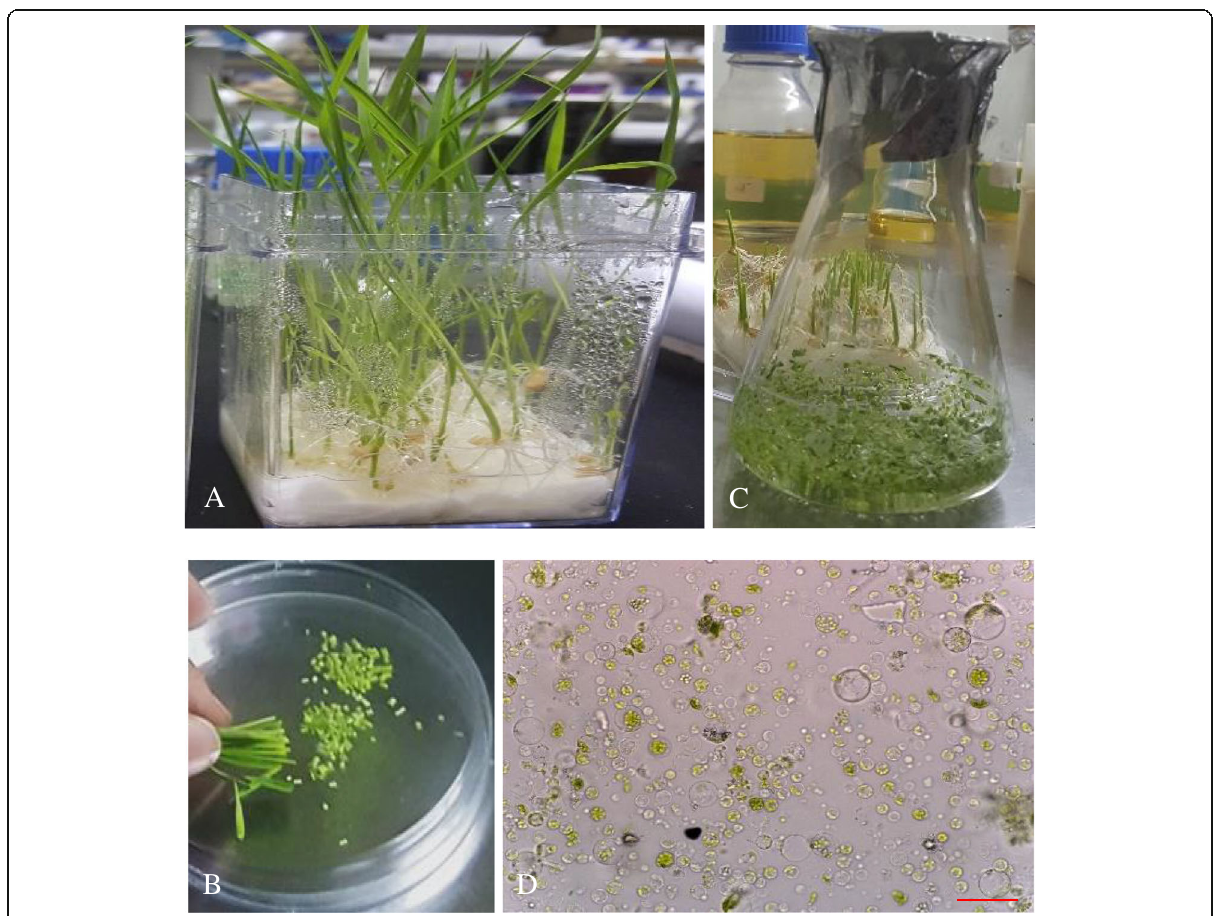
Fig. 1 Fourteen-day-old rice seedlings used for protoplasts isolation ( A ). Stem and sheath of the seedlings were cut into approximately 0.5-mm strips ( B ). The strips were treated with 0.6 M mannitol ( C ) followed by enzymatic digestion. Protoplast image under the microscope ( D ). Bar in ( D ) is 100 μ